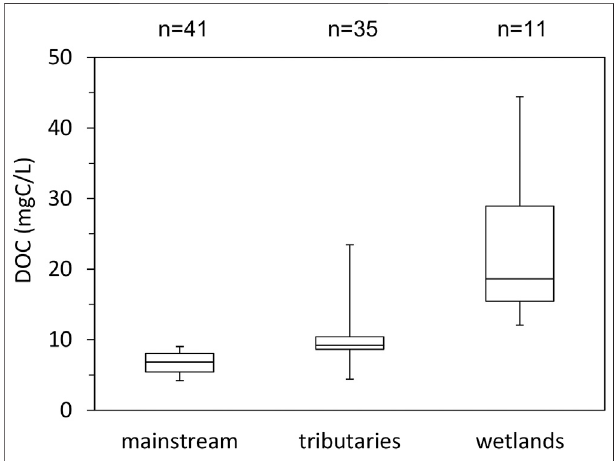
FIGURE 4 | Boxplots showing the distribution of DOC concentration during summer in the Indigirka mainstream and tributaries in 2010 – 2013, and wetlands in 2010 –